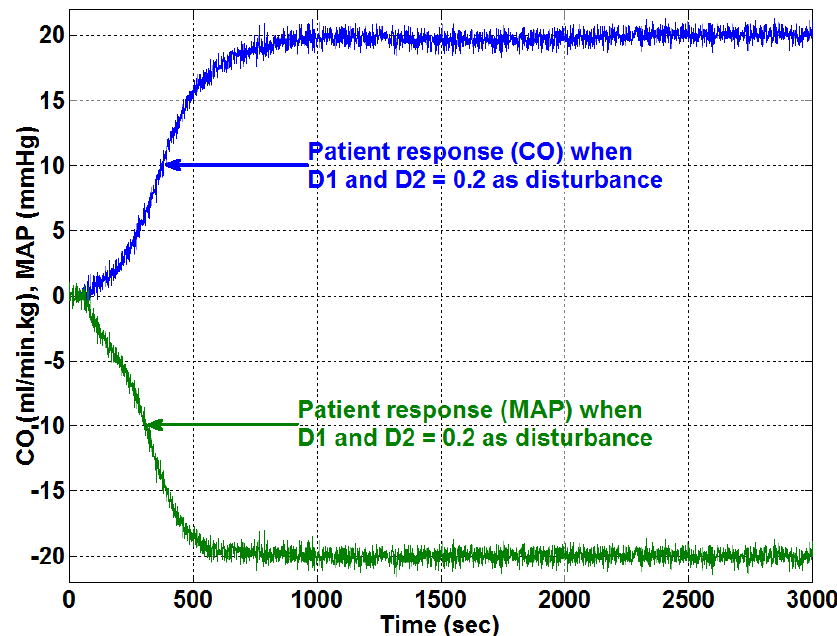
Figure 9: Nominal response with disturbance variance D1=D2=0.2 and set points +20 for CO and -20 for MAP